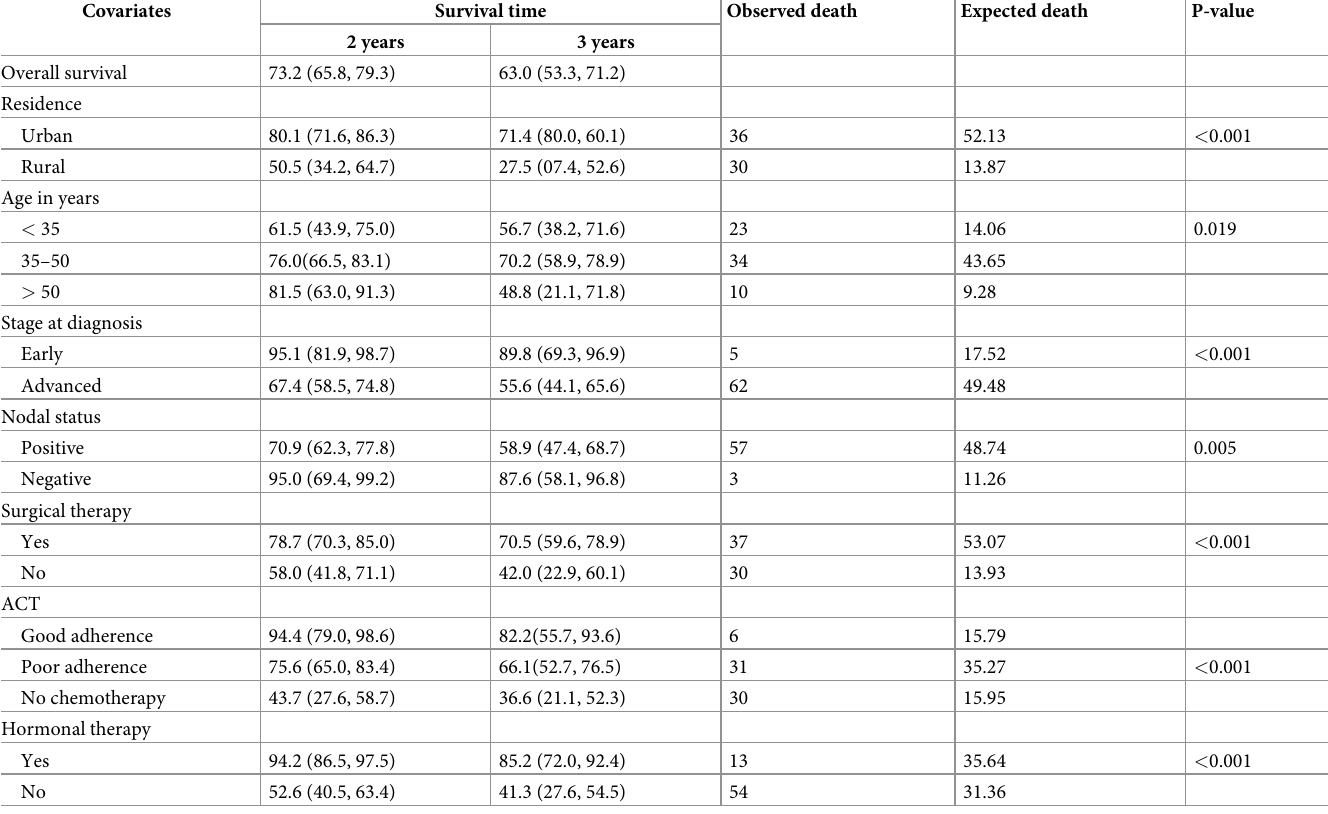
Table 3. Log-rank test for equality of survival function of female breast cancer patients in southern Ethiopia, 2013–2018 (n = 302). Covariates Survival time Observed death Expected death